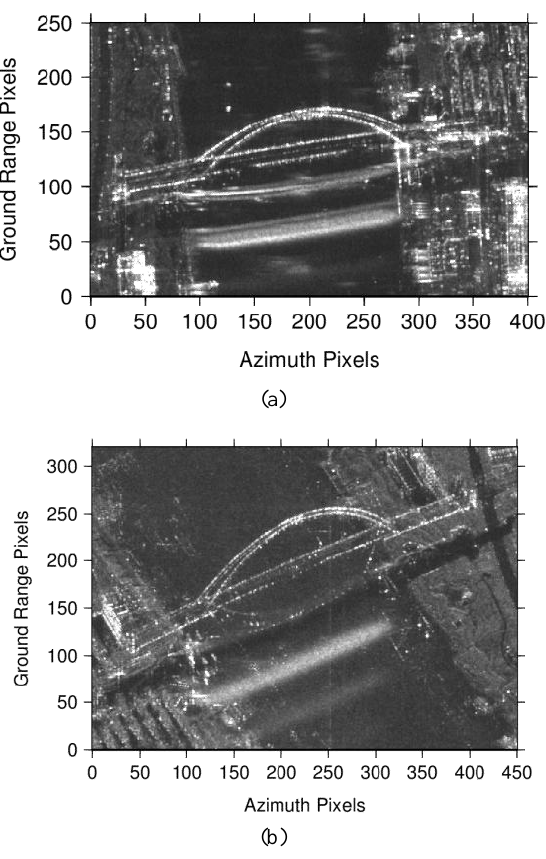
Figure 4. Averaged SAR intensity image (a) Ascending track